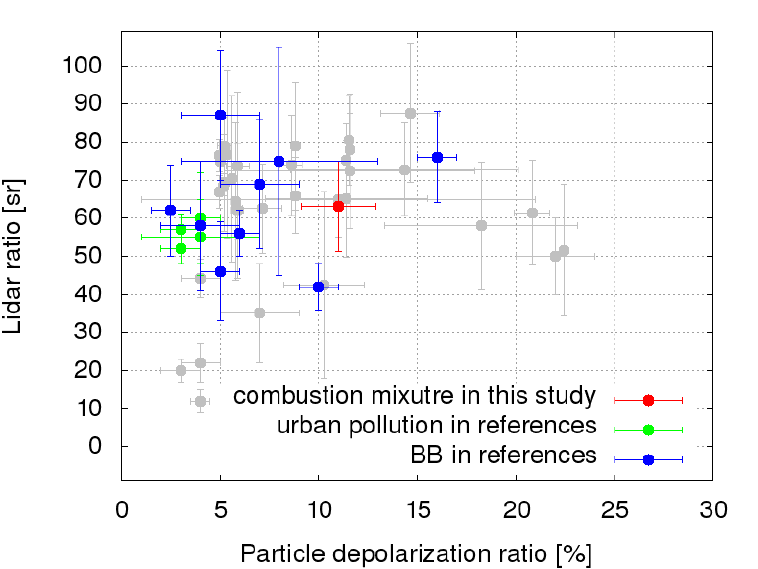
Figure 6. Results of simultaneous measurements in the IR Mie − Rayleigh, UV Mie − Rayleigh and UV Raman channels on 17 November, 2017, 02:30 − 03:00 CET. Figure ( a ) shows the retrieved backscatter coefficients 1064nm (red) and at 355nm (blue); ( b ) the retrieved extinction coefficient at 355nm; ( c ) the VDR and PDR at 355nm; ( d ) LR at 355nm and ( e ) the BAE between 355 and 1064nm. The range resolution of backscatter coefficients, VDR, PDR and BAE, is 37.5m, while the extinction coefficients retrieved using Raman method and LR were calculated with a 150m height smoothed window. The error bars stand for the uncertainties of each measured quantities; the two horizontal lines (black and green) stratified the aerosol layers.